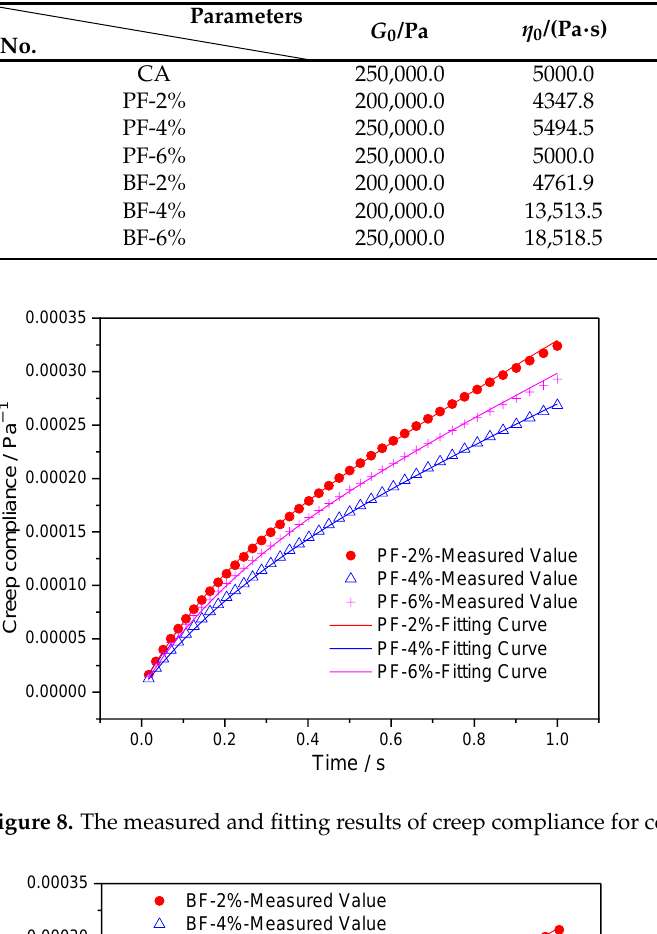
Table 6. The fitting parameters of Burgers model.